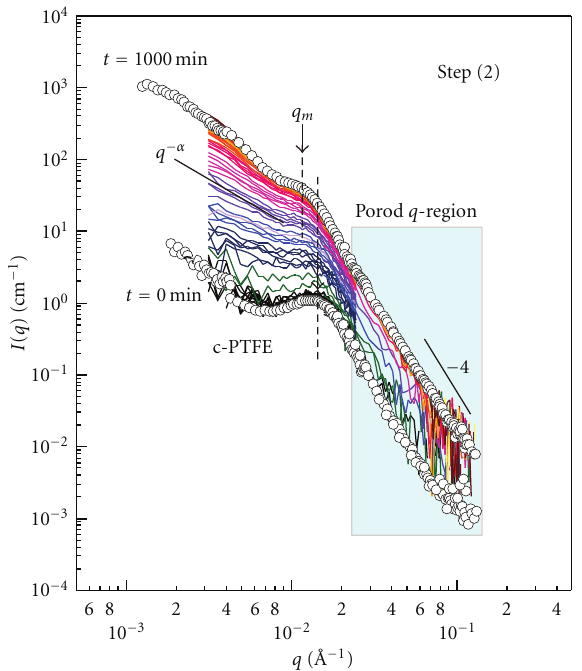
Figure 6: Time-resolved SANS obtained for Preirradiation graft polymerization in crosslinked (c-PTFE) (step (2)). Scattering curves indicated by open circles exhibit that for c-PTFE before polymeri- zation and at 1000 min after starting polymerization. Solid lines indicate scattering curves obtained during polymerization with a measurement step of 10min. A Porod q -region showing q − 4 is indi- cated by a shaded region. A power law q -behavior ( α ) was estimated from lower q according to q − α .